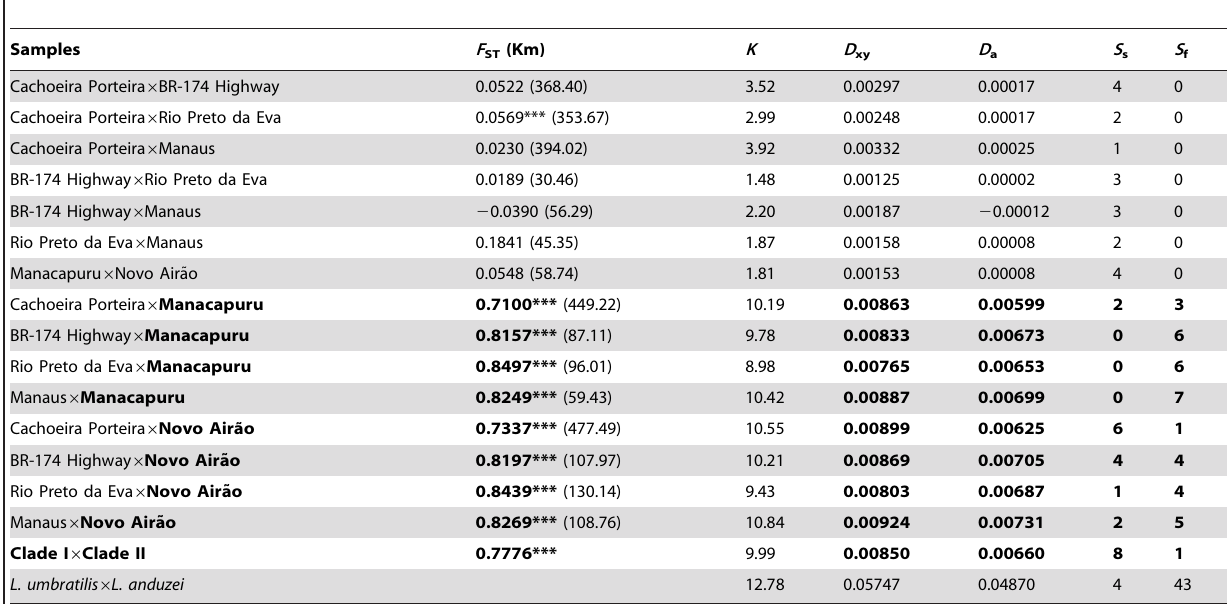
(Table 5), a differentiation degree consistent with those described for populations within species [47]. This result may be due to ongoing gene flow or sharing of a recent common history, as recent population expansion (Table 4, Figures 2 and 4). Taken together, this study suggests that L. umbratilis populations across rivers from the central Amazonian Brazil region may represent an advanced speciation process consisting of two incipient or distinct species that likely initiated their independent evolutionary histories after the complete formation of the Amazonas and Negro Rivers Table 5. Genetic differentiation among samples and haplotype clade of Lutzomyia umbratilis .